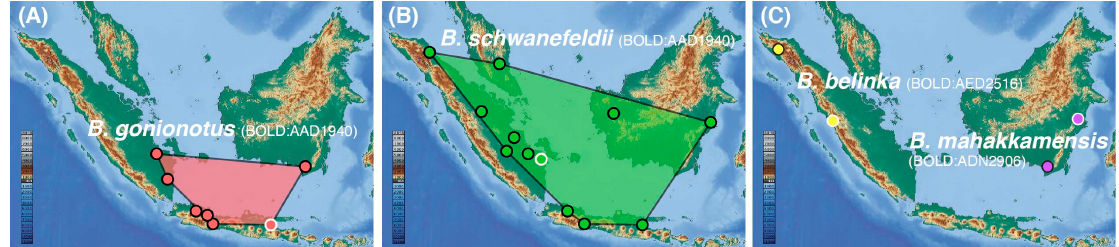
Figure 3. Revised range distribution and type localities (white circle) for ( A ) B. gonionotus (only records in Sundaland with geocoordinates are shown, its range distribution expands northward to Thailand and India), ( B ) B. schwanefeldii (only records in Sundaland are shown), ( C ) B. belinka , and B. mahakkamensis . B. altus occurs in mainland